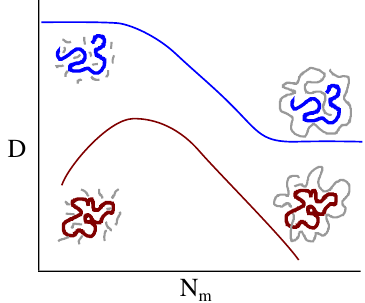
Figure 1. Diffusion of linear (blue) and ring (red) probes in linear matrices (gray). The diffusivity of the linear probe decreases monotonically as the molecular weight of the matrix polymers increases, before reaching a plateau. On the other hand, the diffusivity of ring probes varies non-monotonically. At large N m it decreases without reaching a